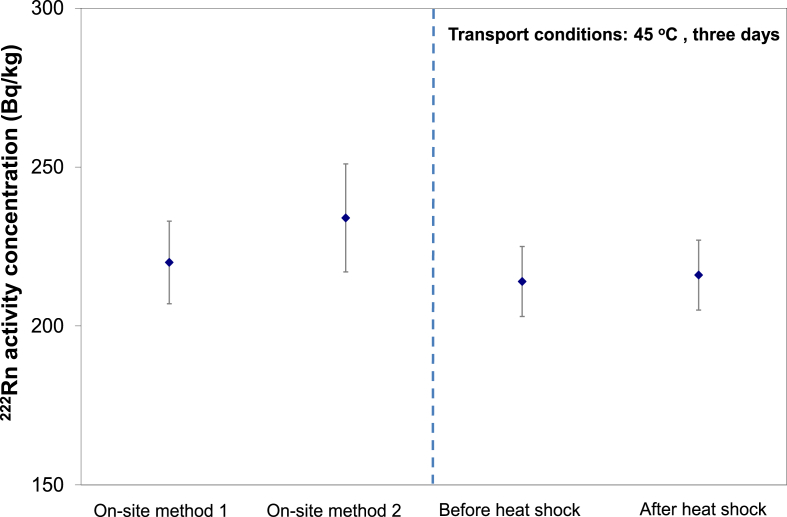
Comparison of radon massic activity results from on-site measurement methods and measurements before and after heat treatment.